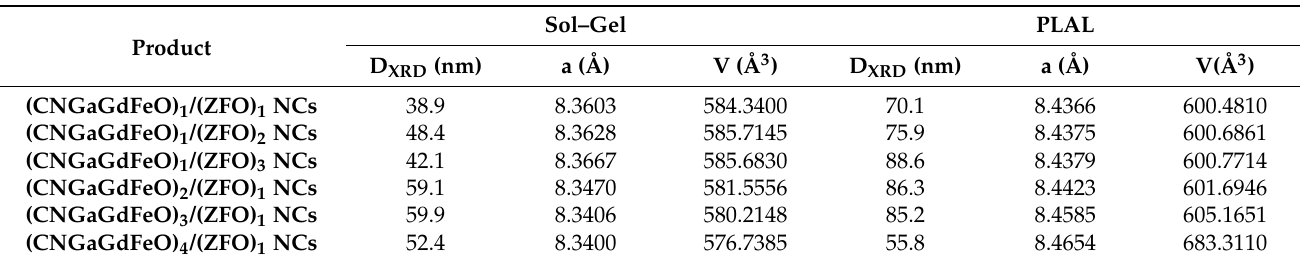
Table 1. Refined structure parameters of CNGaGdFeO NPs, ZFO NPs and (CNGaGdFO) x /(ZFO) y ( x:y = 1:1, 1:2, 1:3, 2:1, 3:1 and 4:1) NCs prepared by sol-gel and PLAL.